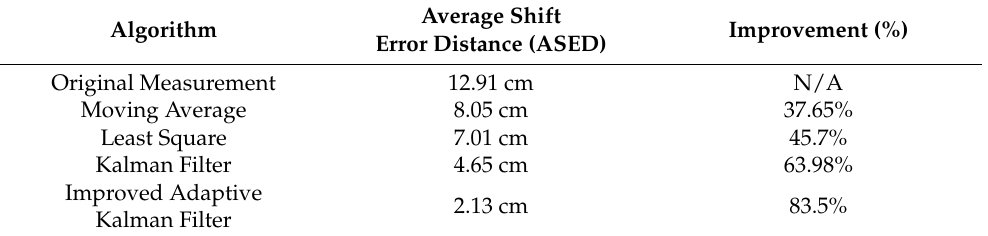
Table 1. Comparison of average drift error distance and improvement range.